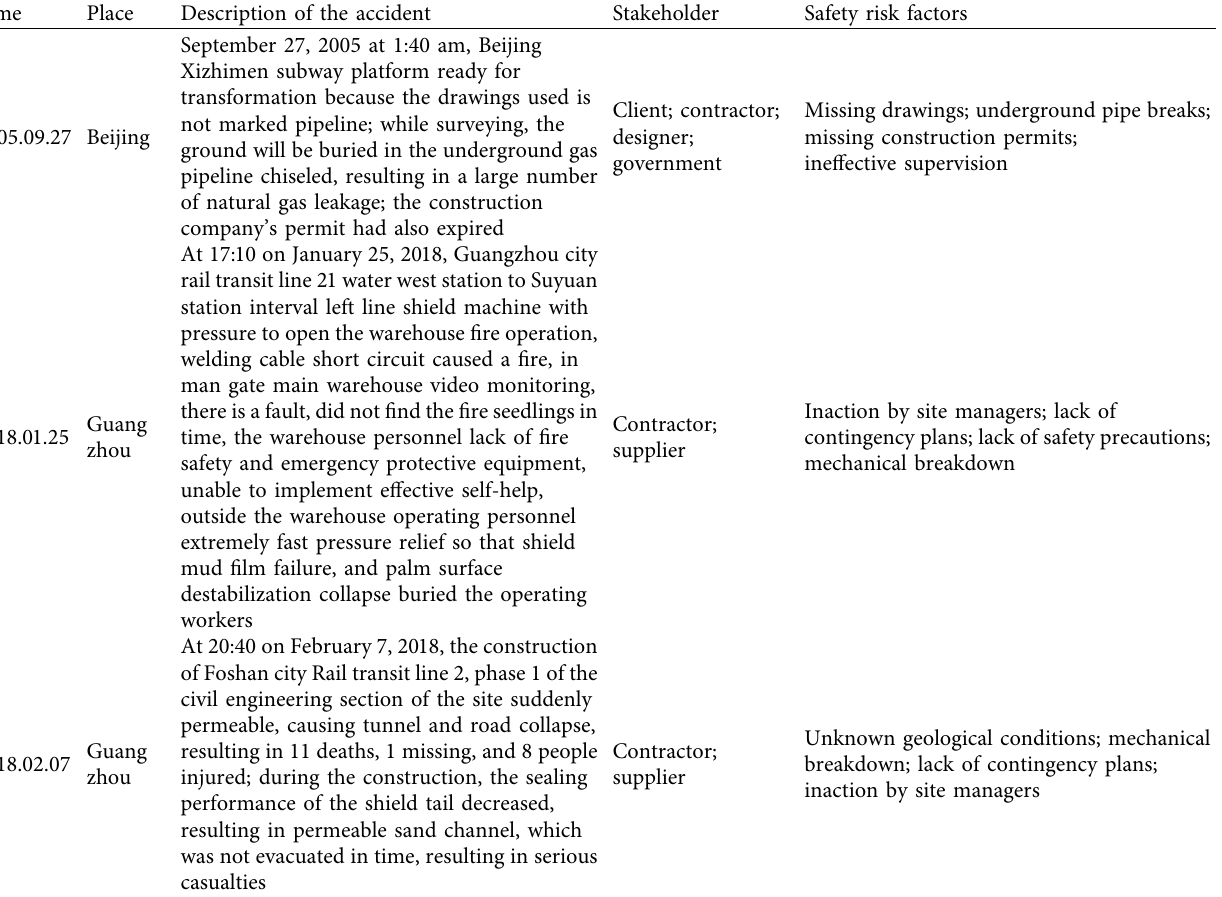
Table 2: Three examples of incident case identification results.